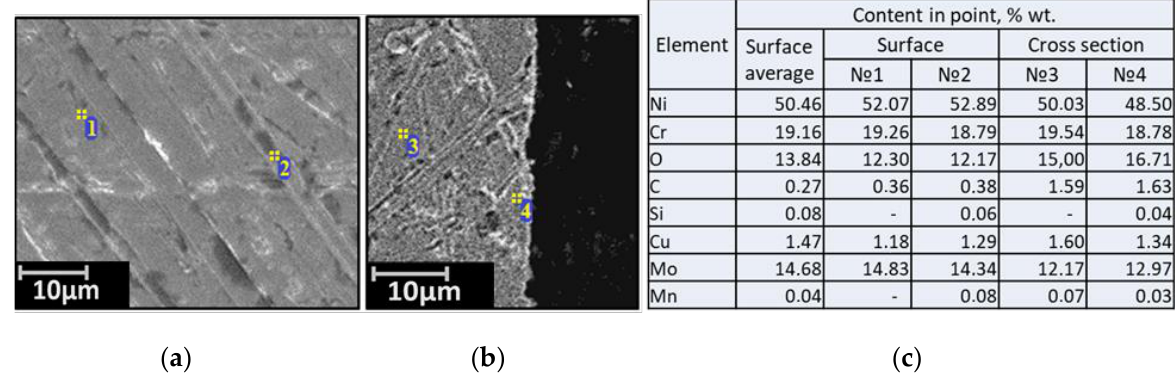
Figure 2. Micrographs of the surface ( a ), the cross-section ( b ), and the elemental composition ( c ) of the source material Hastelloy C2000.